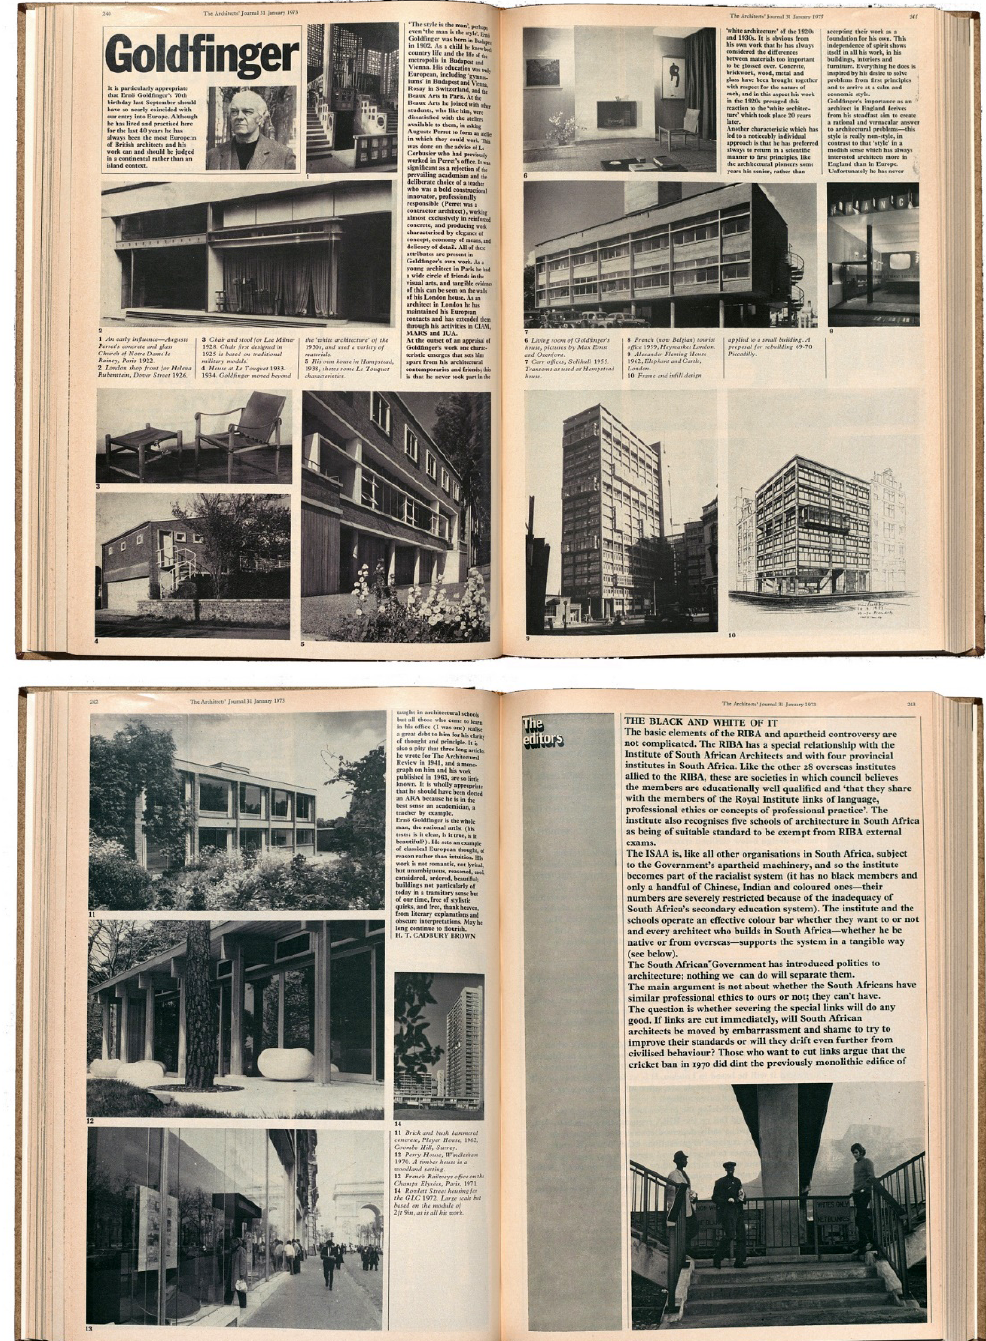
Figure 9. Cadbury-Brown H. T. (1973). “Goldfinger,” Architects’ Journal , 157 . Urban Planning, 2019, Volume 4, Issue 3, Pages